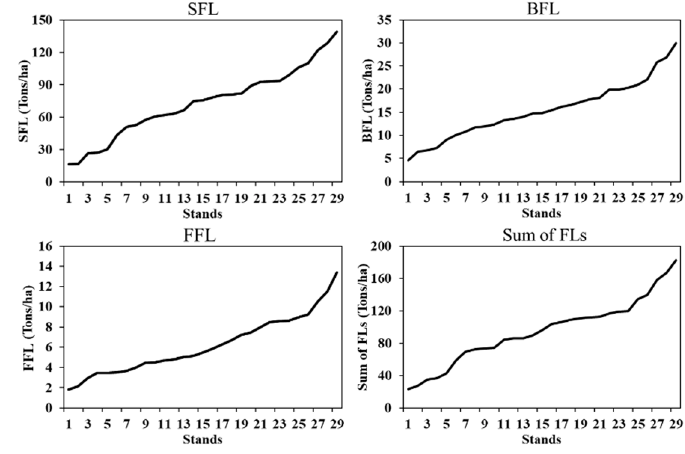
Figure 7. Fuel load (FL) value distribution of 29 stands.